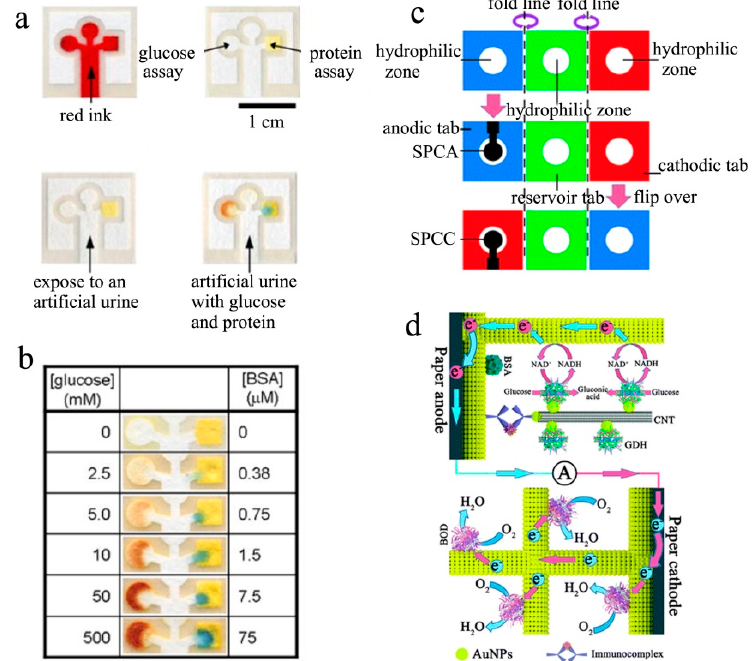
Figure 1. ( a ) Structure diagram and working principle of the chromatography paper-based biosensor. ( b ) The color changes of this paper-based sensor for different concentrations of glucose and BSA [49]. Copyright 2007 John Wiley and Sons. ( c ) Schematic representation and ( d ) working principle of the 3D-m-OBFCAD [50]. Copyright 2014 Royal Society of Chemisty.